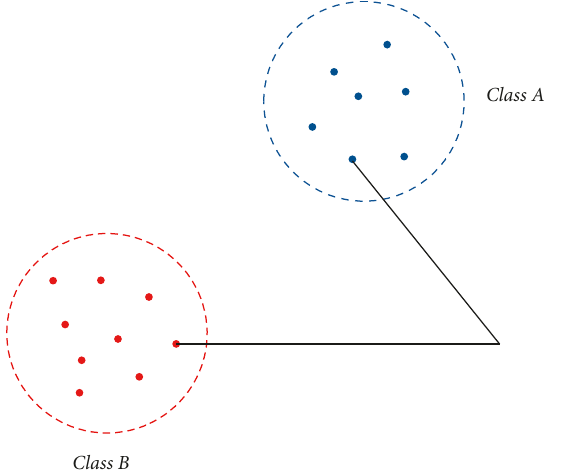
Figure 5: Principle of using the vector angle cosine.